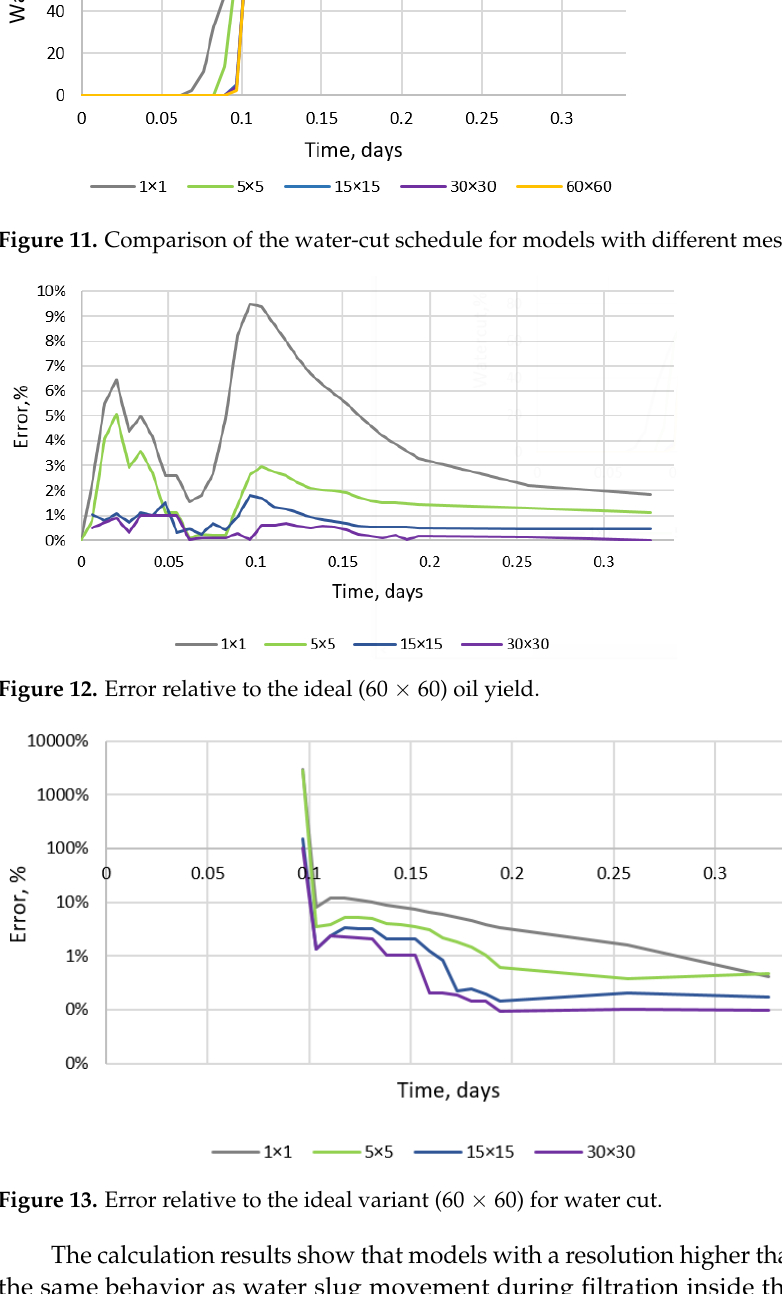
Figure 13. Error relative to the ideal variant (60 × 60) for water cut.